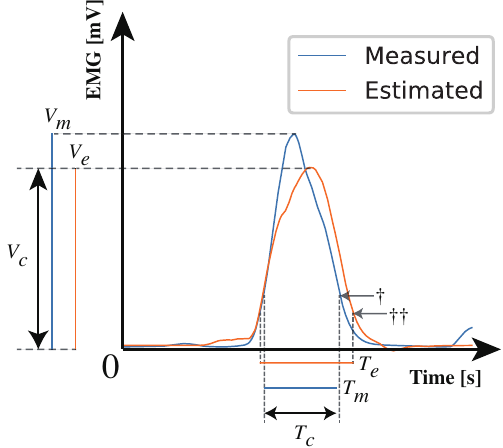
Figure 8. T m and T e are the times at which EMG values were measured and estimated over the thresholds. V m and V e are the maximum values for the measured and estimated EMG values over the thresholds, respectively. T c and V c are the time length and volume, respectively, where T m and T e and V m and V e overlap. †: A threshold for the measured EMG, ††: A threshold for the estimated EMG. Both thresholds are calculated based on a specific